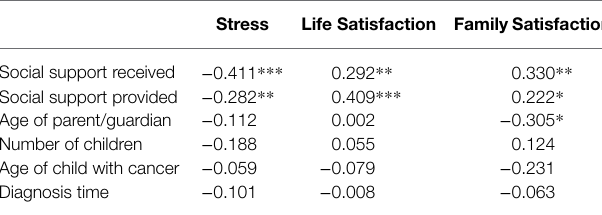
TABLE 6 | Correlations between social support received and provided and clinical and sociodemographic variables with stress, life and family satisfaction.